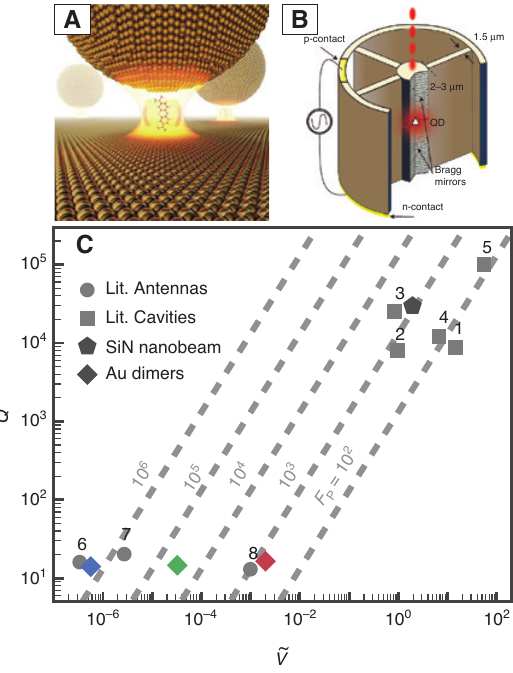
Figure 1: Reported quality factors and mode volumes for dielectric cavity and plasmonic antenna